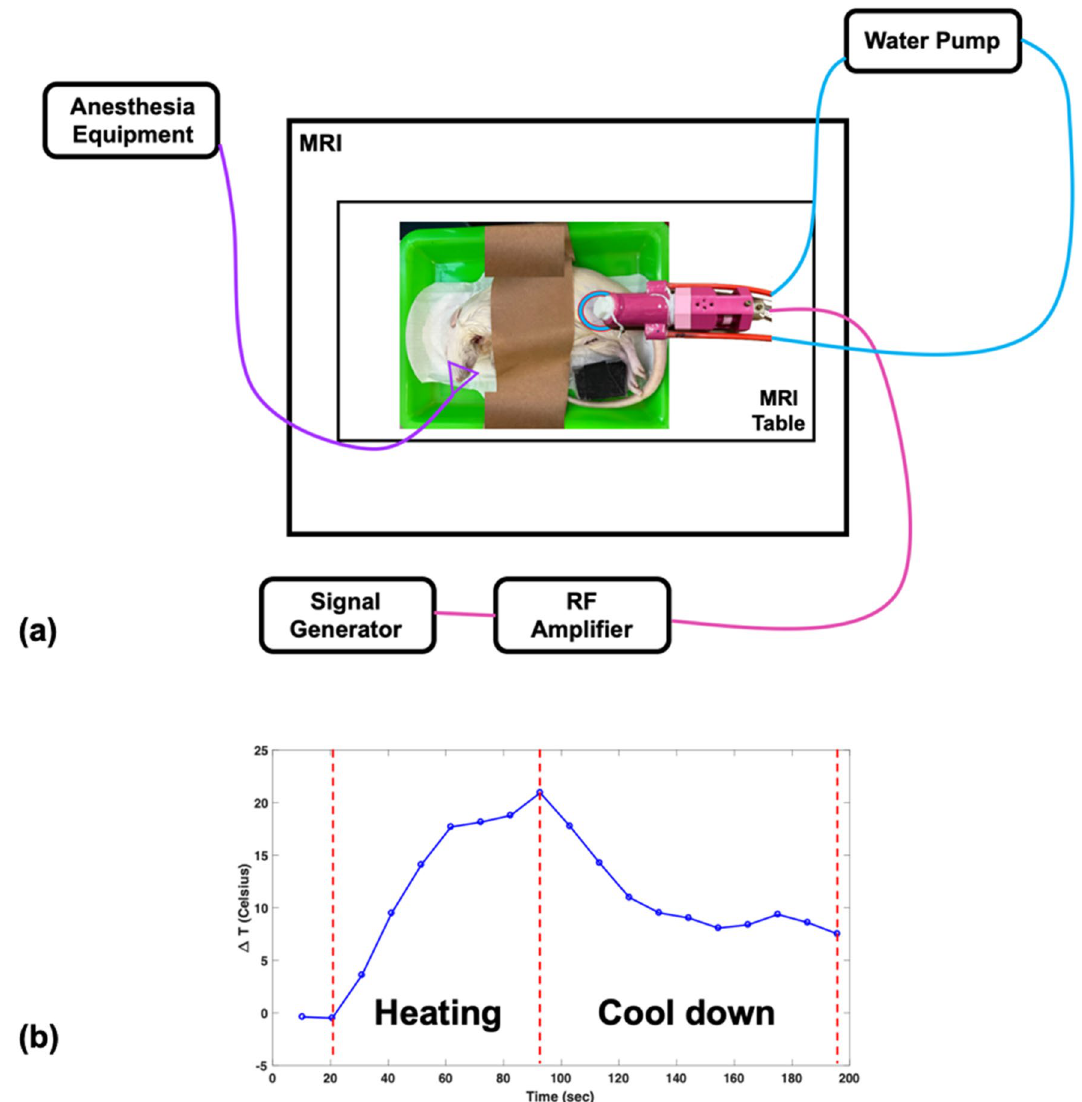
Figure 4. ( a ) Setup of HIFU experiment. The reflecting HIFU transducer, derived from the RF amplifier, was placed above the rat thigh or pork tenderloin, and the WICS coil was mounted around the transducer. ( b ) The temperature response shows the heating procedure of the HIFU experiment. HIFU power was turned on for an ultrasonic dose of 30 w/60 s then turned off for tissue cool-down until end of 1) Pork tenderloins: Pork tenderloins were purchased from the local supermarket and placed in the scan room at room temperature for two hours before the experiment. The experimental setup is shown in Fig. 2(g) and described above. The experimental setup and anatomical localization scan took approximately 20 min. T2-weighted images were used for positioning. After T2 images were acquired, thermal mapping both without and with HIFU ablation was performed using spoiled GRE pulse sequences. After scanning for 30 s, HIFU ablation was applied at 30 W for 60 s, and then HIFU power was turned off to allow the tissue to cool-down. Ablation procedure is shown in Fig. 4(b). 2) Rat: Deceased rats were stored frozen. Before the experiment, deceased rats were soaked in room temperature water to thaw for two hours and placed in the scan room at room temperature for one hour. Fur on the rat thighs were shaved to improve deposition of ultrasound beam into the tissue. Rats were placed in the right recumbent position without WICS coil to obtain reference images. Rats were then moved to the left recum- bent position, and the WICS coil was placed on the right hind thigh inside the receive coil. The experimental setup, process and MRI protocols are the same as those mentioned in the “Pork tenderloins” subsection. The SNR comparison study was performed on the pork tenderloins (250–350 g, n = 7) and hind legs of deceased rats (250–350 g, n = 5), using the body coil as the transmitting coil and receiving coil. The experiment setup and process are the same as those mentioned in the “Temperature measurement comparison study” section.